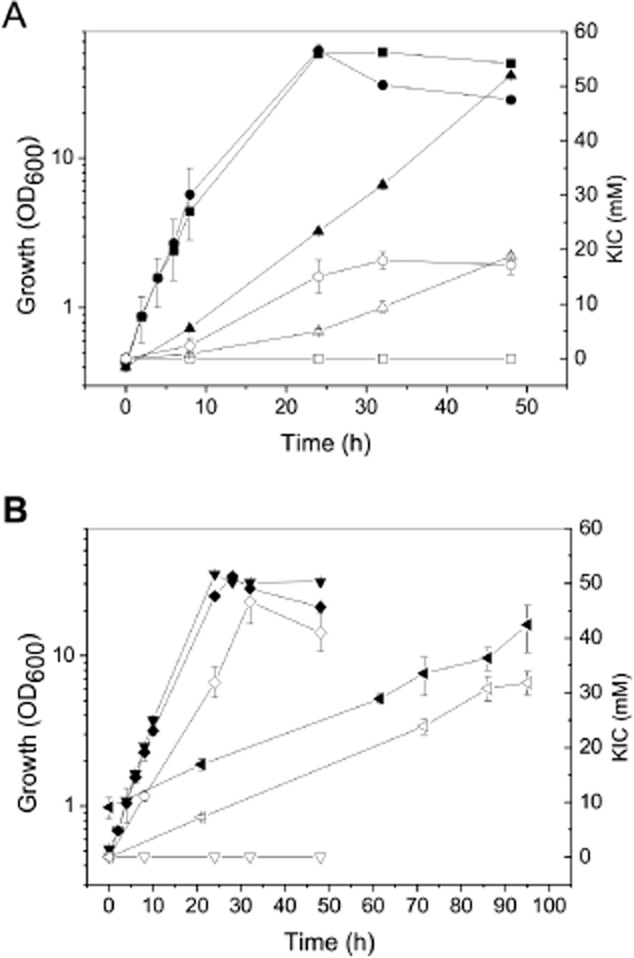
Growth and KIC formation of different C. glutamicum strains in shake flasks with CGXII minimal medium containing 4% (w/v) glucose.A. MV-Leu20 without supplements (growth, ▪; KIC, □), MV-Leu20 ΔilvE supplemented with 1 mM l-isoleucine (growth, •; KIC, ○) and SH-KIC20 without supplements (growth, ▴; KIC, △).B. MV-LeuF1 without supplements (growth, ▾; KIC, ▽), MV-KICF1 without supplements (growth, ◂; KIC, ◃) and MV-KICF1 with 1 mM l-isoleucine (growth, ♦; KIC, ⋄). The data represent mean values and standard deviations obtained from three independent cultivations.